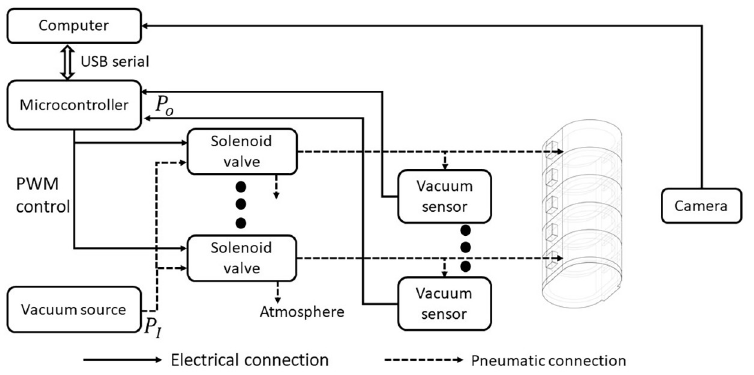
Fig 3. The framework of the whole system. The control system for the soft robots is composed of electrical connections (solid lines) and pneumatic connections (dashed lines).